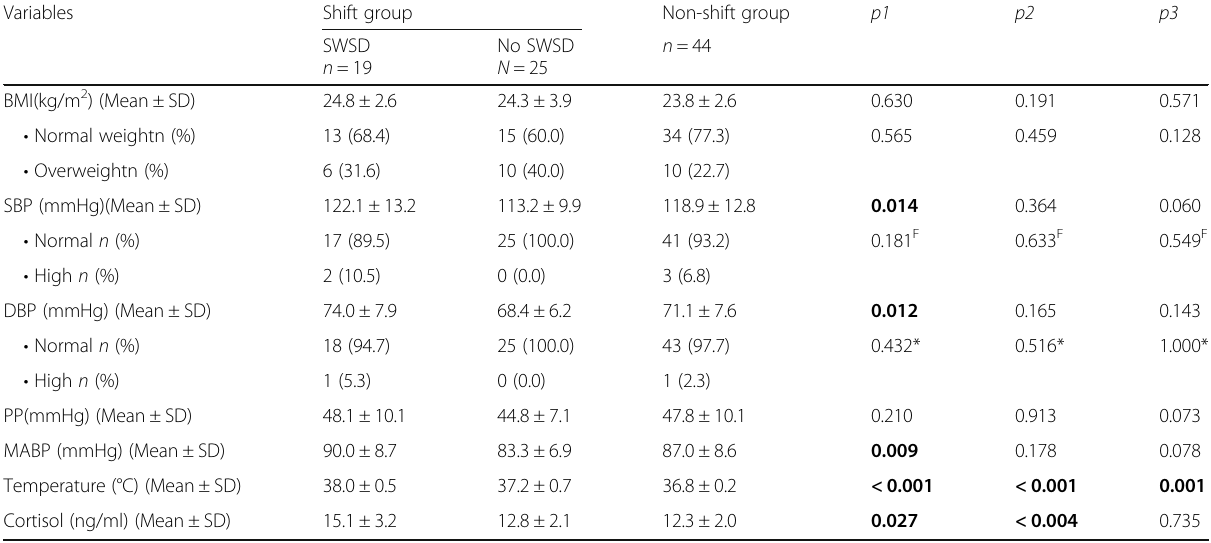
Table 3 Comparison of anthropometric and biophysical profiles between SWSD, No SWSD and non-shift Groups Variables Shift group Non-shift